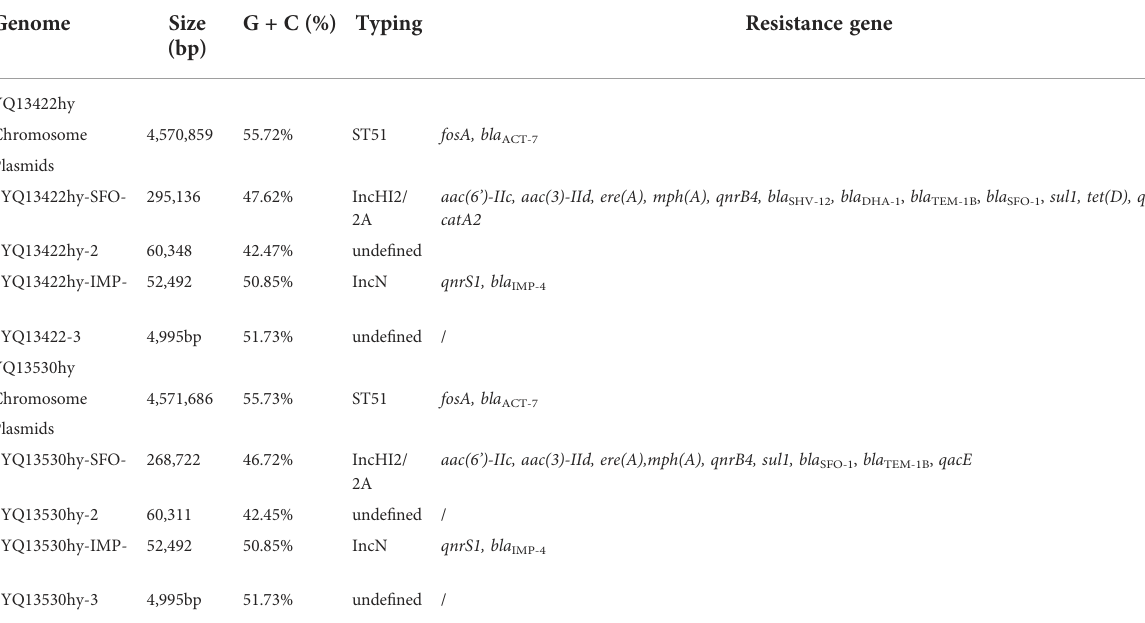
TABLE 2 Genome information and acquired antibiotic resistance genes of E. hormaechei YQ13422hy and YQ13530hy. Genome Size Resistance